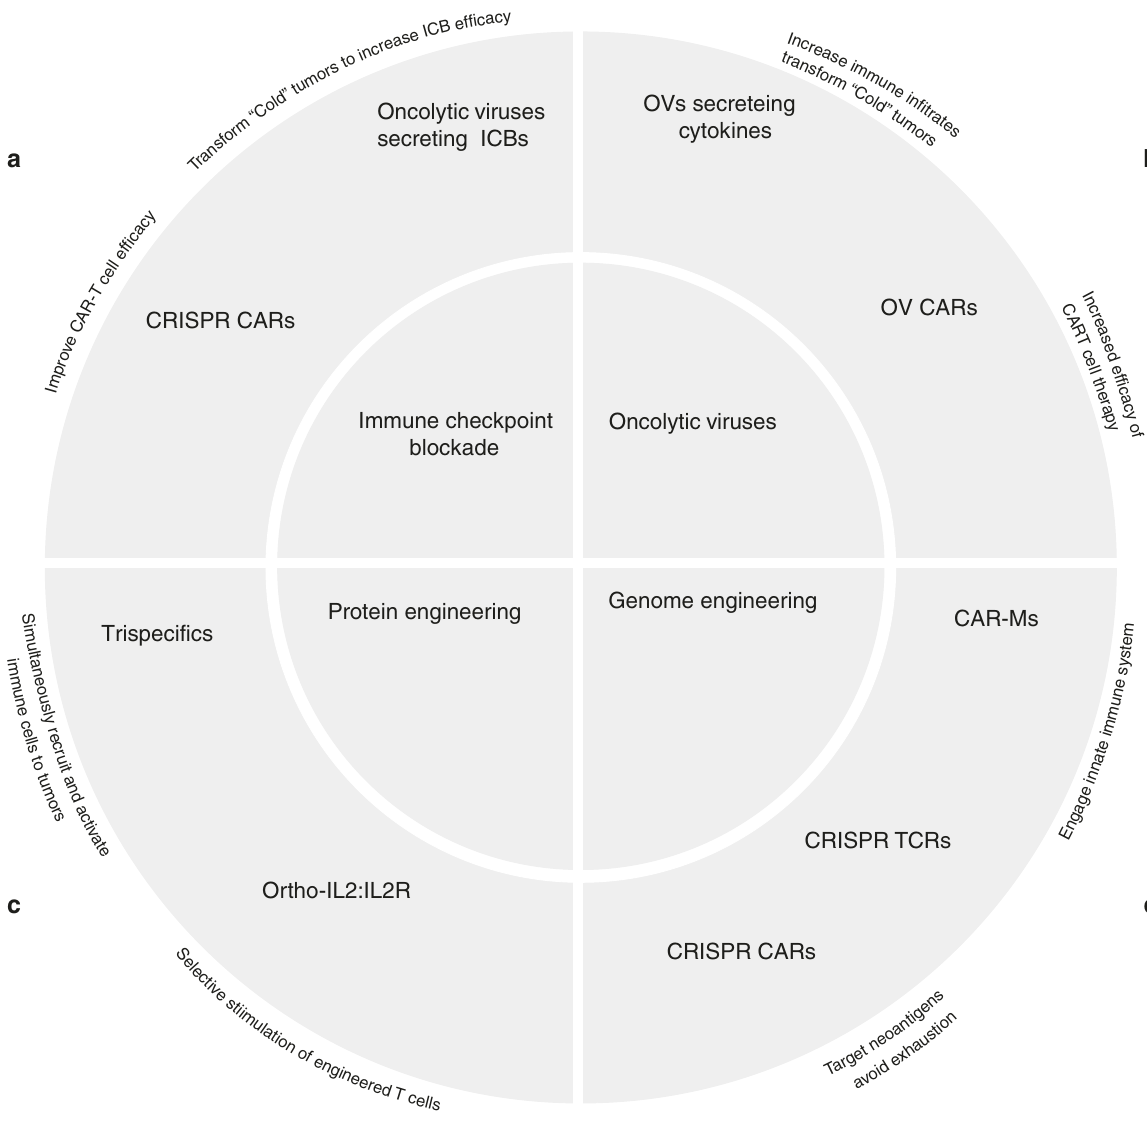
Fig. 1 Overview of new tools immunotherapeutic developments and multiplexed approaches to improve their ef fi cacy. a Immune checkpoint blockade can be augmented with oncolytic viruses and CAR T cells. b Oncolytic viruses can be engineered to secrete cytokines or combined with engineered T cells. c Advancements in protein engineering have allowed the development of trispeci fi cs, orthogonal cytokine receptor pairs, which allow for selective stimulation of these engineered T cells. d Genome engineering has produced CAR-Ms and genome editing with CRISPR allow for multiple editing of multiple genes in T